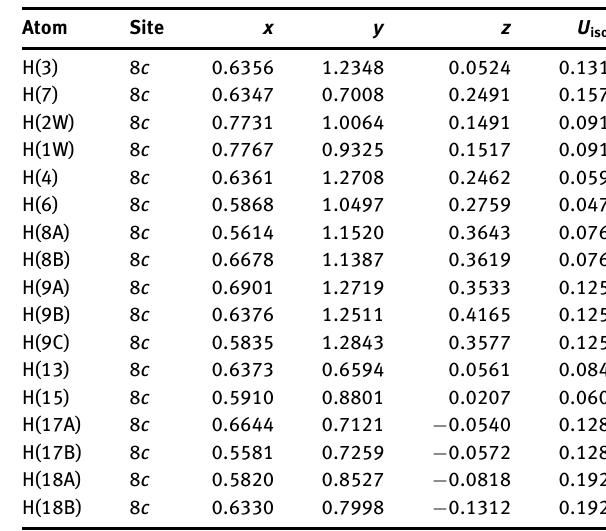
Table 2: Fractional atomic coordinates and isotropic or